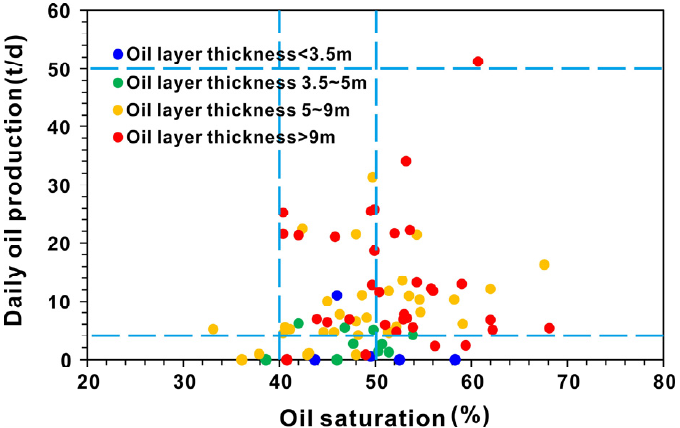
Figure 18. Relationship between oil saturation and daily production of oil testing in the Chang 7 1-2 sub-member (oil test results).